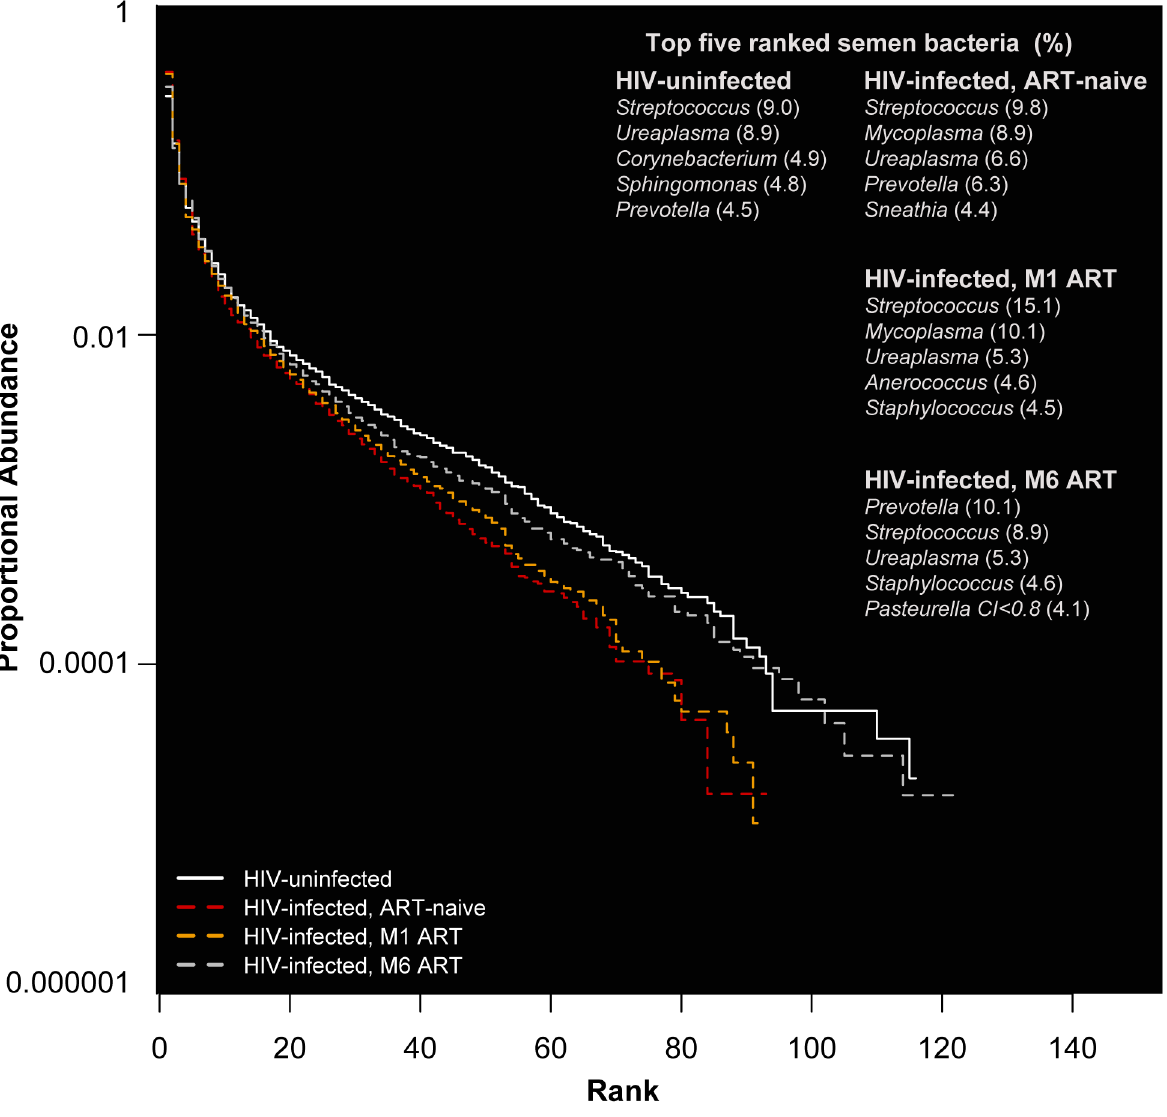
Figure 1. Rank abundance and the five most abundant semen bacteria in uninfected versus HIV-infected men over the course of antiretroviral treatment. In this rank abundance plot, richness is the distance the plot extends along the x-axis, and evenness is low slope. Extreme dominance is a high y-intercept. HIV uninfected is both richer and more even than the ART- naı¨ve, but by 6 months ART, the relationship converges onto the HIV uninfected. The five top-ranked semen bacteria from each group are listed, with its respective group-level proportional abundance in parenthesis.